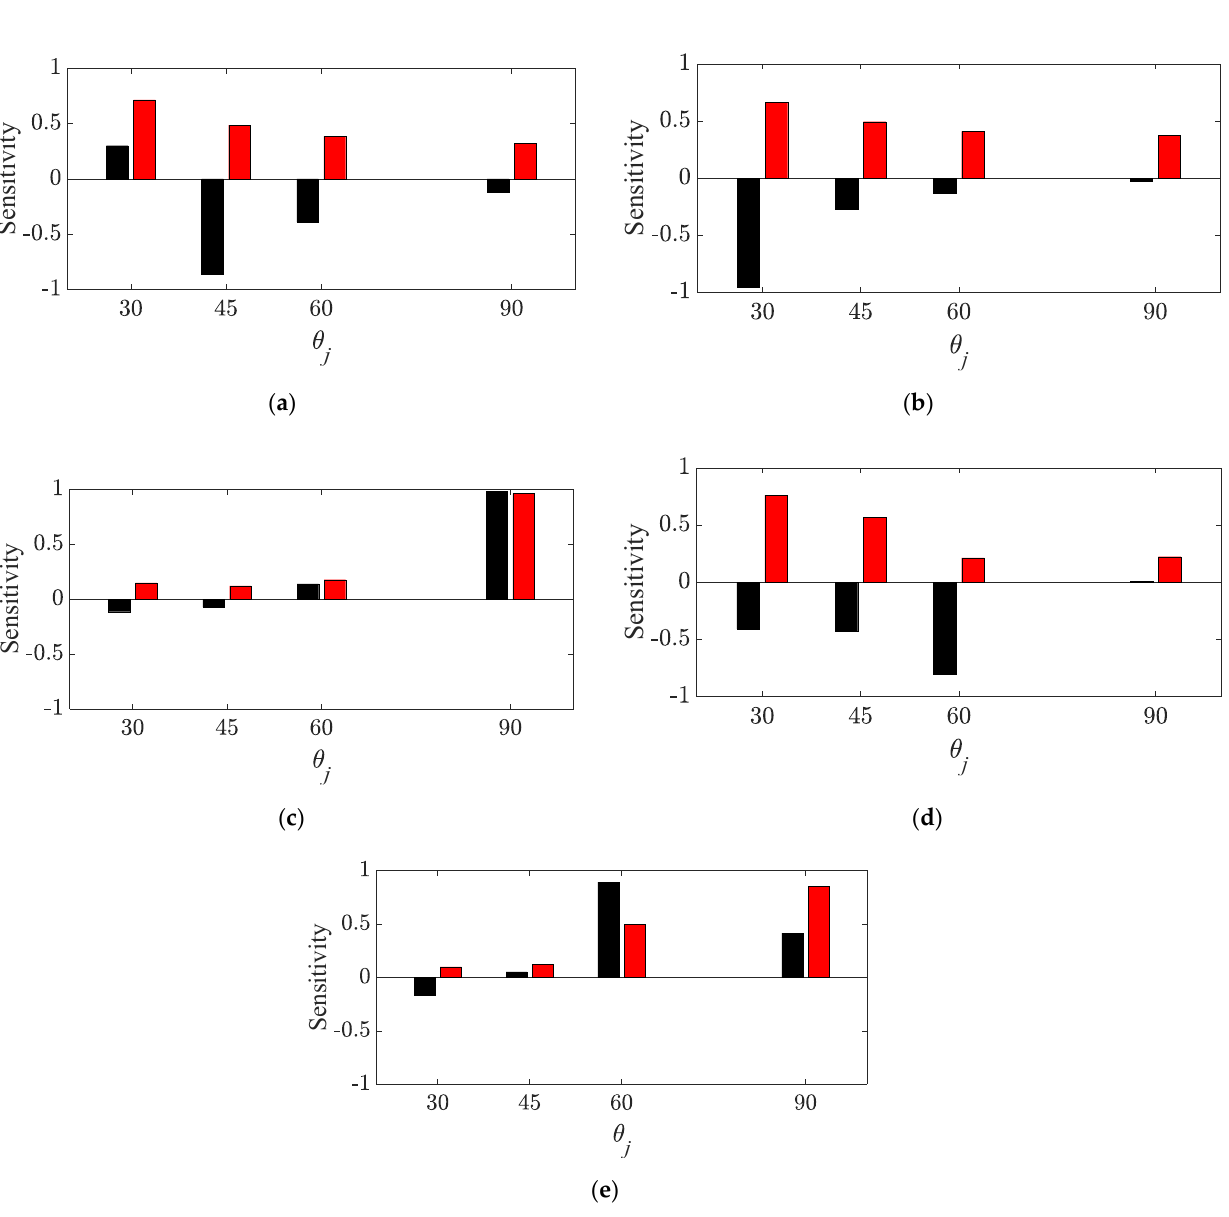
Figure 7. Sensitivity analysis results, : the mass-normalized equivalent viscous damping coefficient, : the viscous damping coefficient ratio between the θ l carbon fiber angle and the reference one. ( a ) First mode (first bending); ( b ) second mode (first twisting); ( c ) third mode (second twisting); ( d ) fourth mode (second bending); ( e ) fifth mode (third bending). The sensitivity indices for the structural stiffness show different trends for the two different parameters: the equivalent stiffness and the partial stiffness from the carbon